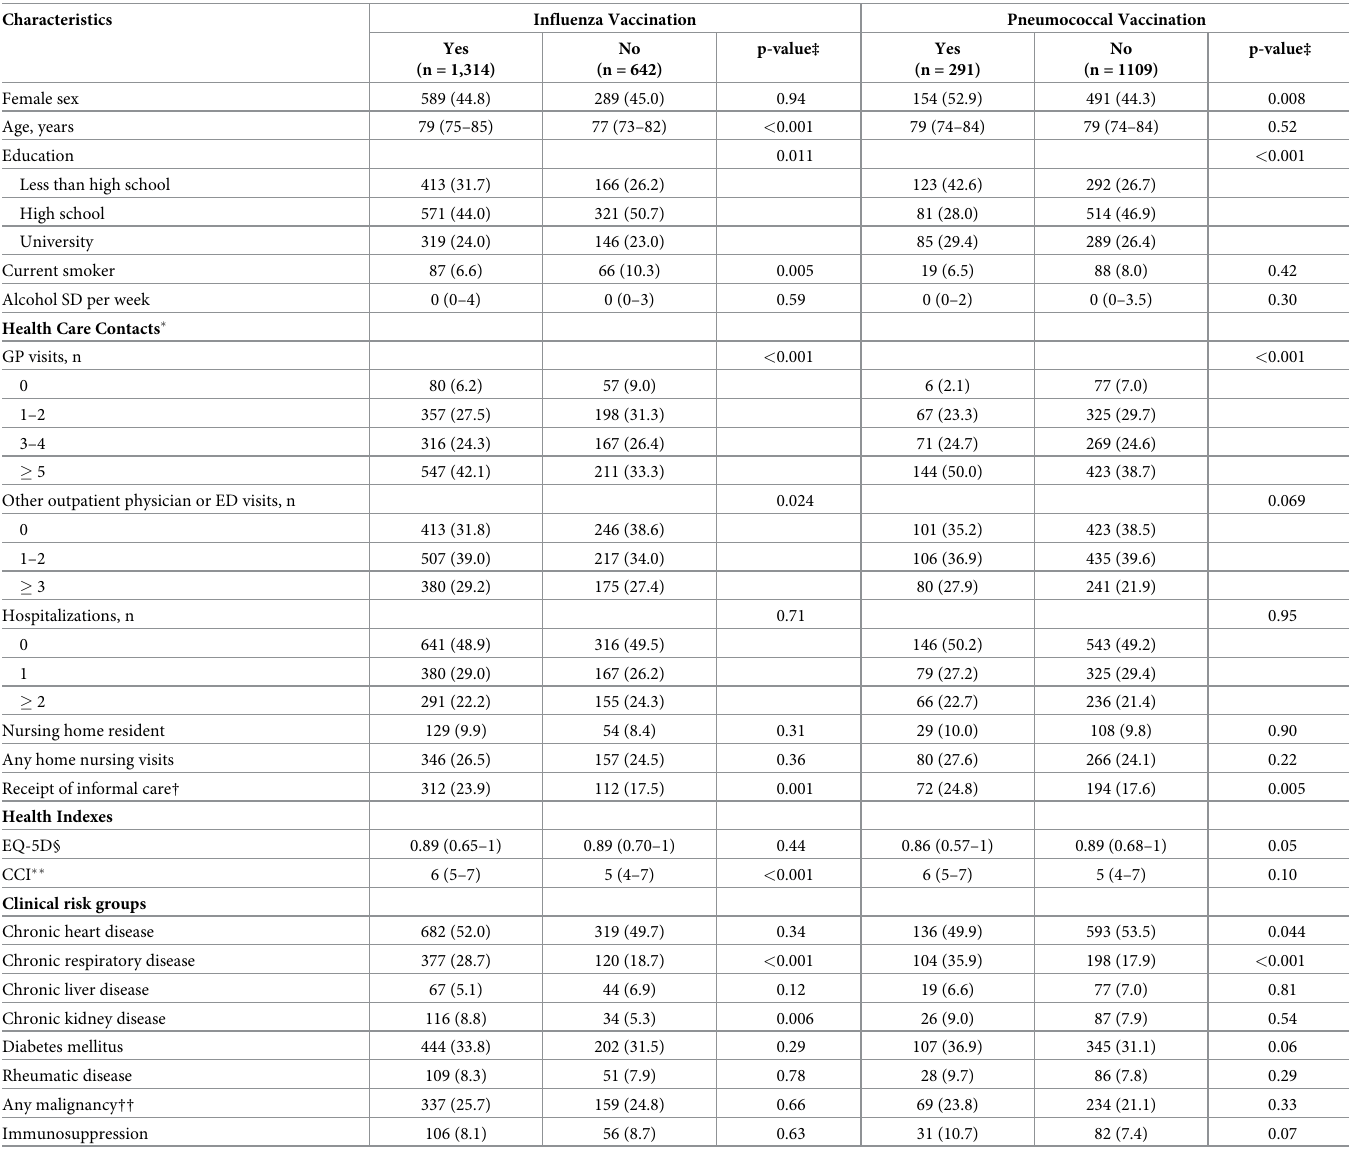
Table 1. Patient characteristics according to vaccination